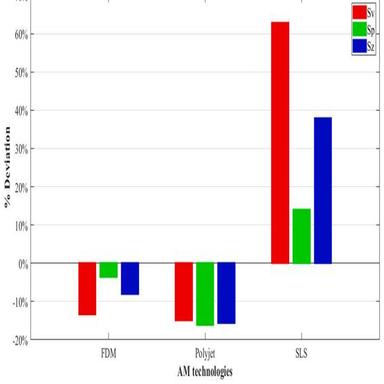
Areal roughness maximum values % deviation.